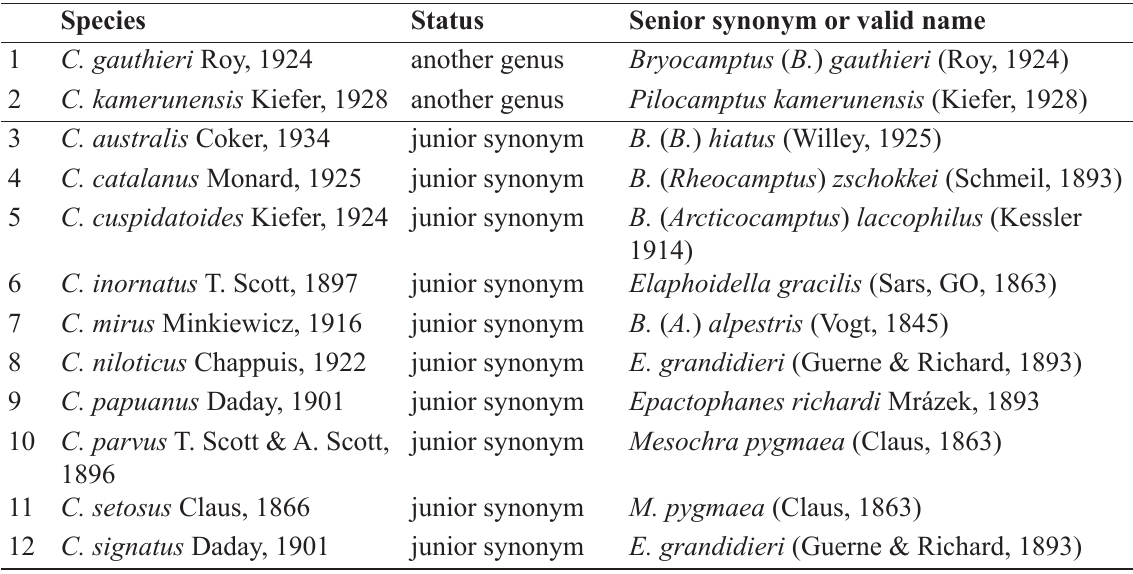
Table 4. List of species of Canthocamptus Westwood, 1836, valid according to WoRMS (Walter & Boxshall 2021), that should be treated as junior synonyms or belong to a different genus, according to K. Lang